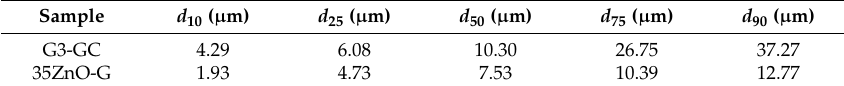
Table 1. Particles size distributions (in volume percentages) of G3-GC and 35ZnO-G. d 10 , d 25 , d 50 , d 75 , d 90 : particle diameters corresponding respectively to 10%, 25%, 50%, 75%, and 90% of the cumulative size distribution curve. Sample d 10 ( µ m) d 25 ( µ m) d 50 ( µ m) d 75 ( µ m)